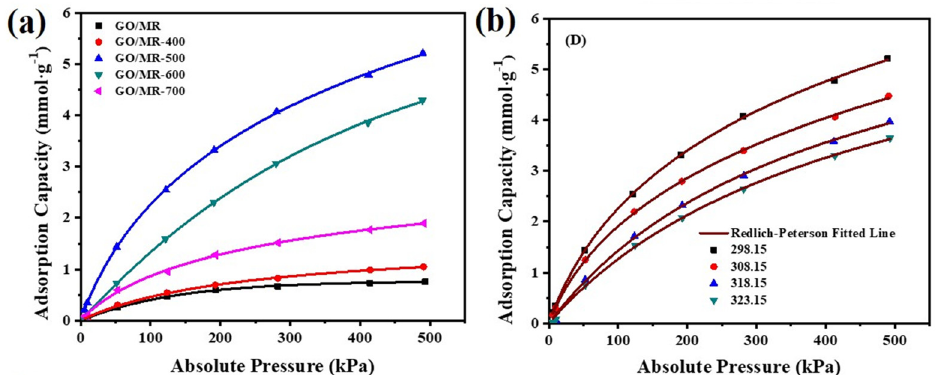
Figure 6. ( a ) CO 2 adsorption isotherms at 298.15 K for GO(0.25)/MR and GO(0.25)/MR-derived, nitrogen-rich porous carbon materials obtained at different activation temperature. ( b ) Redlich–Peterson isotherm models on experimental CO 2 adsorption at different temperature for GO(0.25)/MR-500.